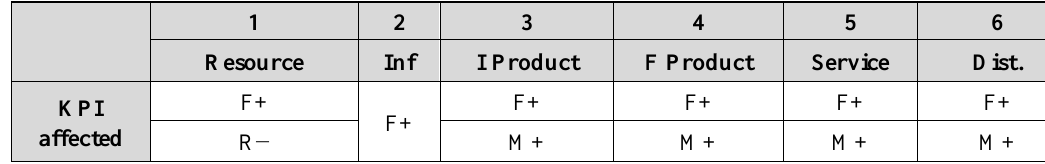
Table 5. The relation between KPI effect and exchange types